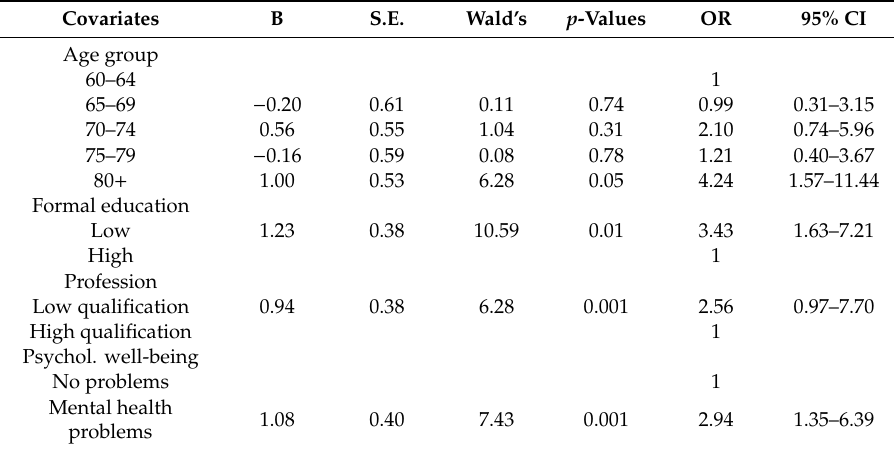
Table 3. Final multivariate logistic regression